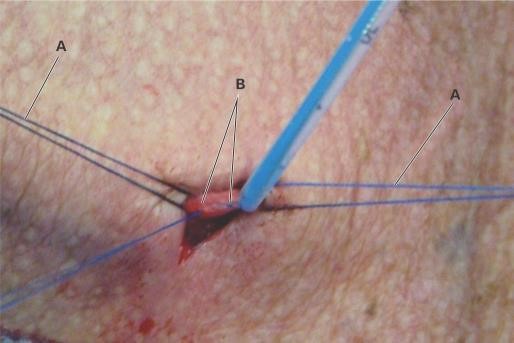
Dissection of the external jugular vein (EJV) to insert a long-term catheter. (A) Proximal and distal repair of the EJV; (B) Venorrhaphy, avoiding distal ligature of the EJV, maintaining flow through the vessel.